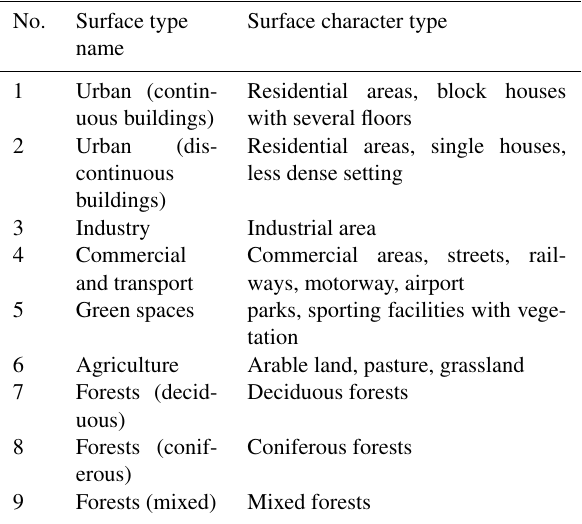
Table 5. Land use types based on the CORINE classification. For number of measurement values ( n ) for each surface type for each instrument/parameter, see the